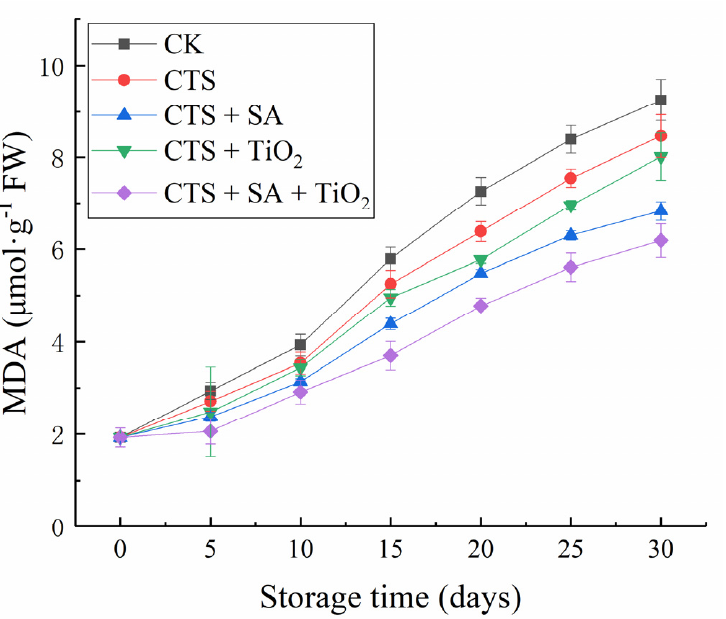
Figure 3. Effect of different coatings on the content of MDA in blackcurrant during 30-day storage at 4 °C .